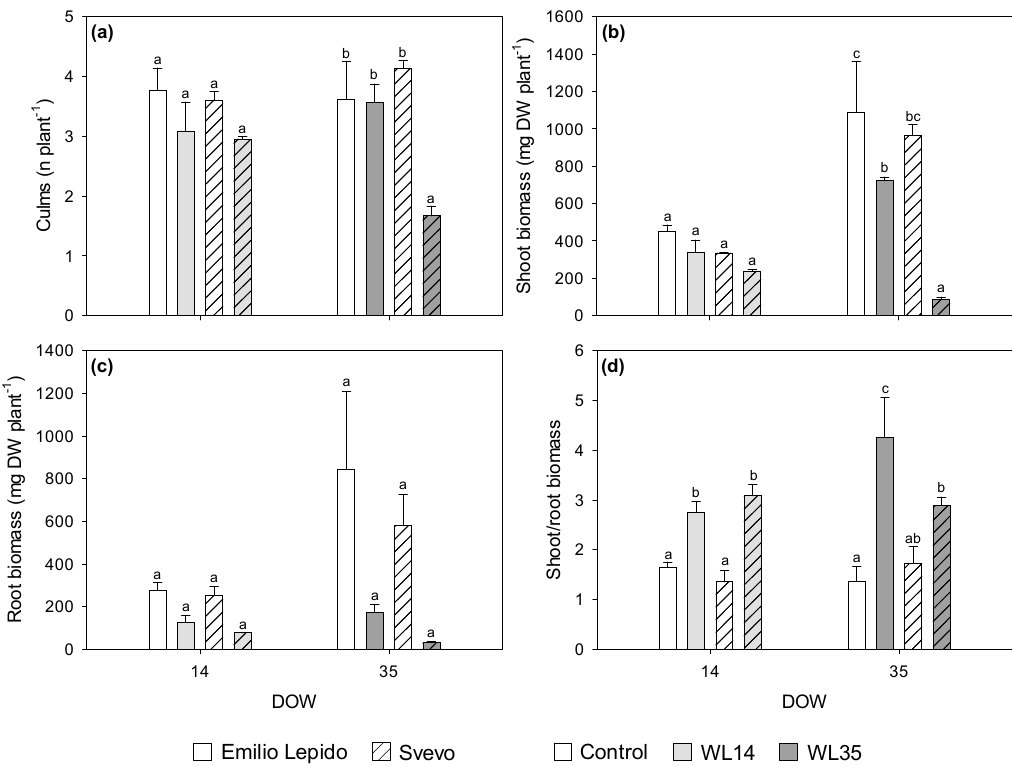
Figure 7. ( a ) Number of culms per plant ( b ), shoot biomass ( c ), root biomass, and ( d ) shoot-to-root ratio of the durum wheat cultivars Emilio Lepido (solid) and Svevo (pattern) subjected to 0 (i.e., control; white), 14 (i.e., WL14; light gray), or 35 (i.e., WL35; dark gray) days of waterlogging (DOW). Data are mean ± standard deviation. DW: dry weight. For each waterlogging duration, according to Tukey’s post hoc test ( p ≤ 0.05), different letters indicate significant differences among means ( p ≤ 0.05).